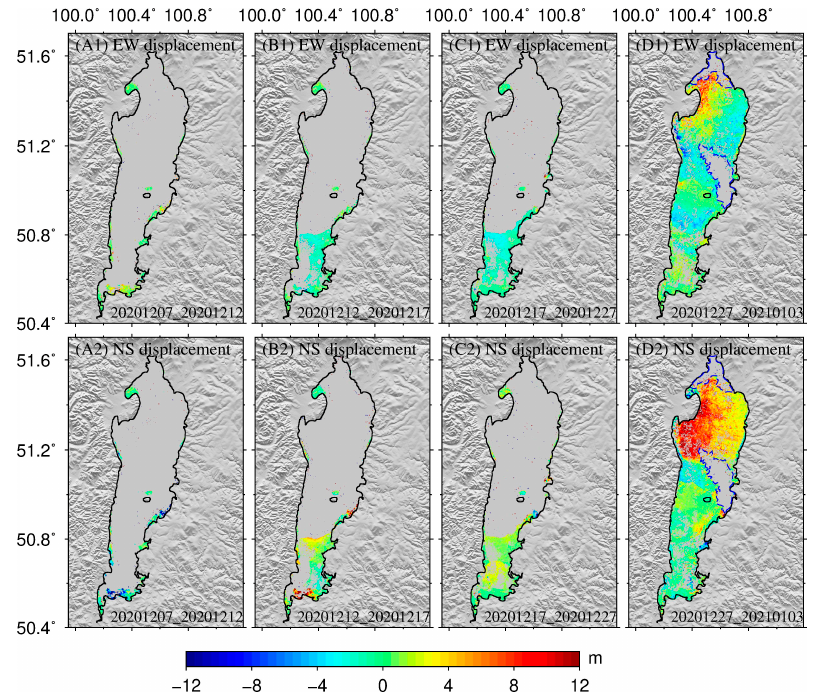
Figure 5. ( A1 – D2 ) represent the results of horizontal displacements of Lake Khovsgol in the EW and NS directions in the first stage. It is superimposed on 3 Arc-Second Global SRTM Digital Elevation Model (DEM) with 90 m resolution. The area marked by the dashed blue line in the figure is the missing signal due to cloud cover occlusion. Displacement values are positive for the eastern and northern directions.